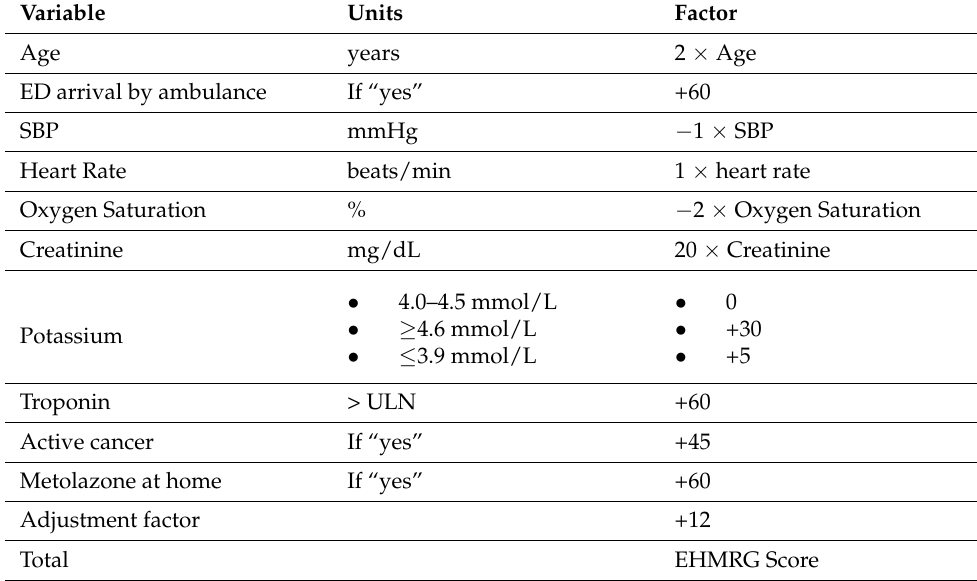
Table 1. EHMRG Score